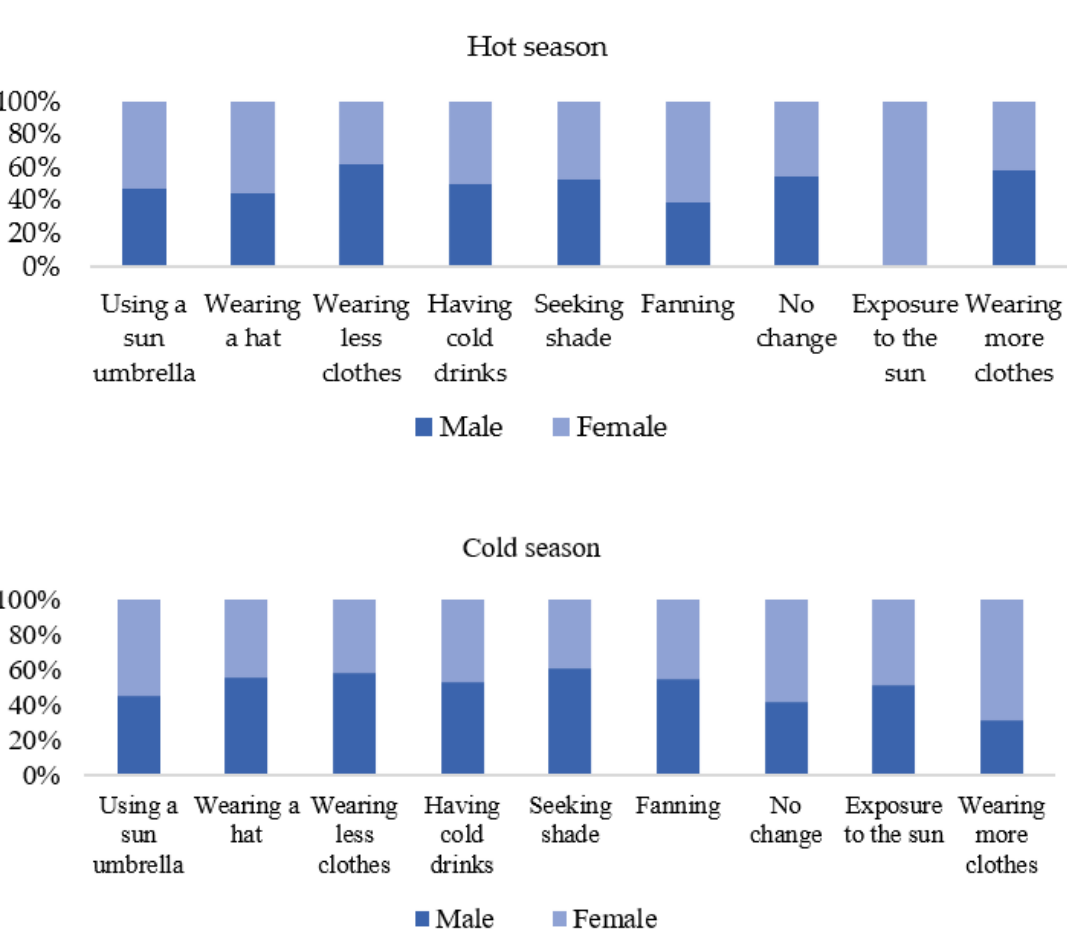
Figure 14. Selection rate of male and female adaptive behaviors in different seasons.